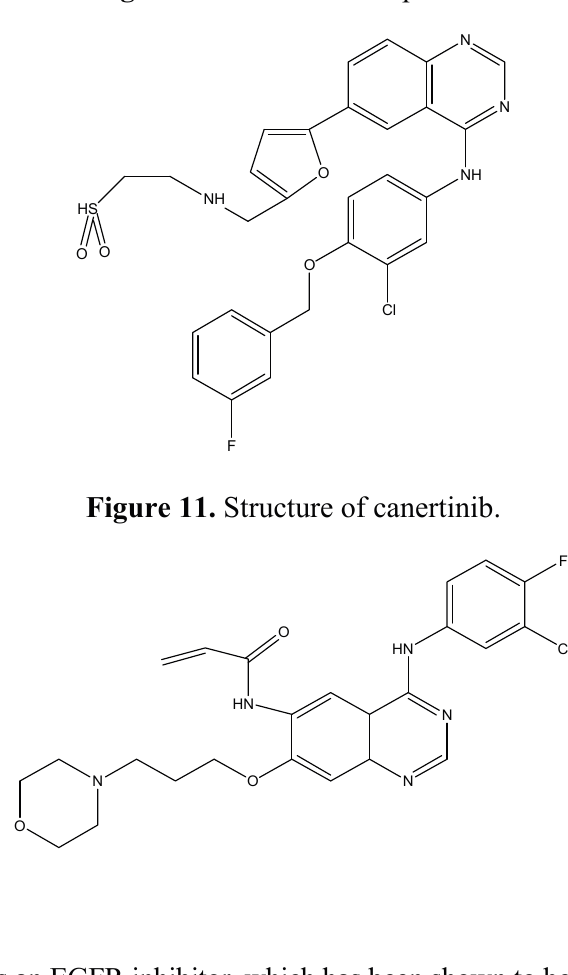
Figure 10. Structure of lapatinib.